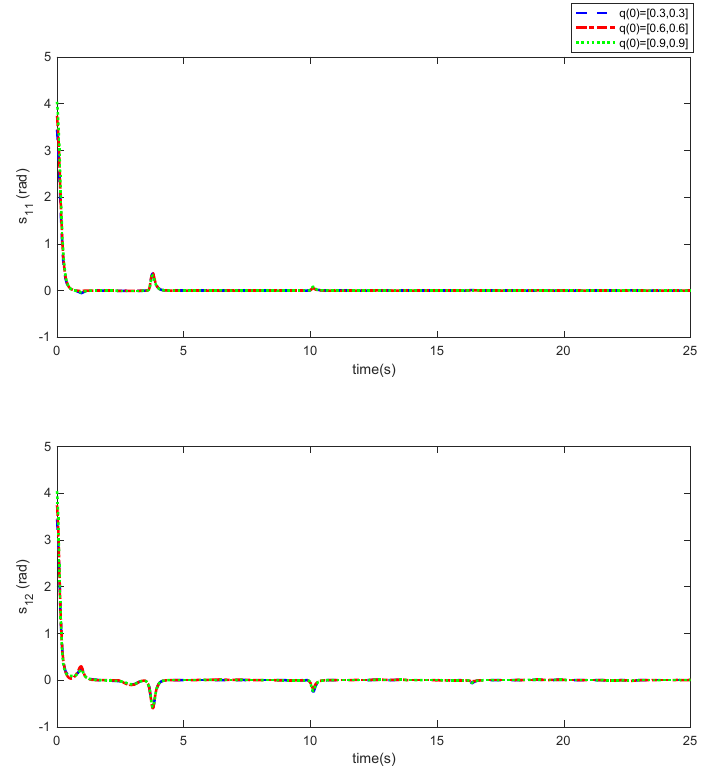
Figure 4. Sliding surface in Scenario 1.